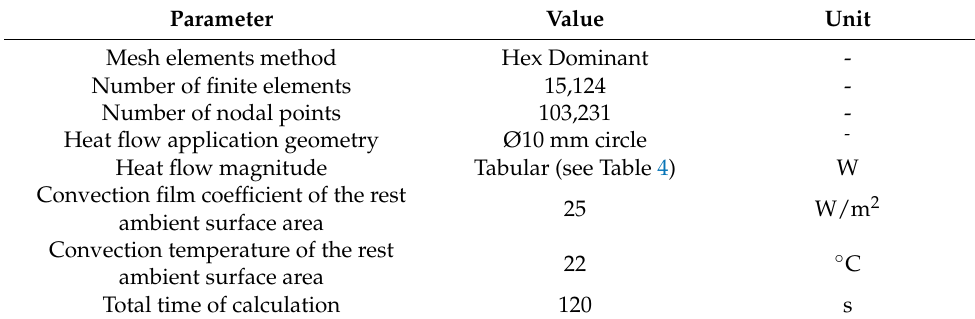
Table 5. FE numerical simulation data of the first stage of analysis.